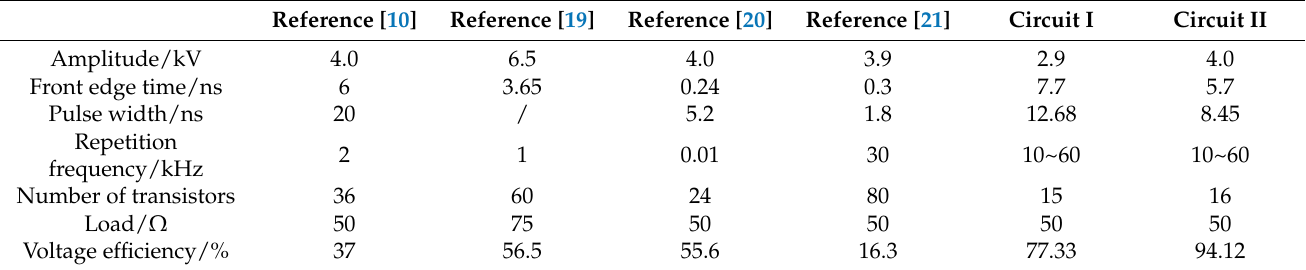
Table 2. Parameter comparison of nanosecond Marx generators based on avalanche